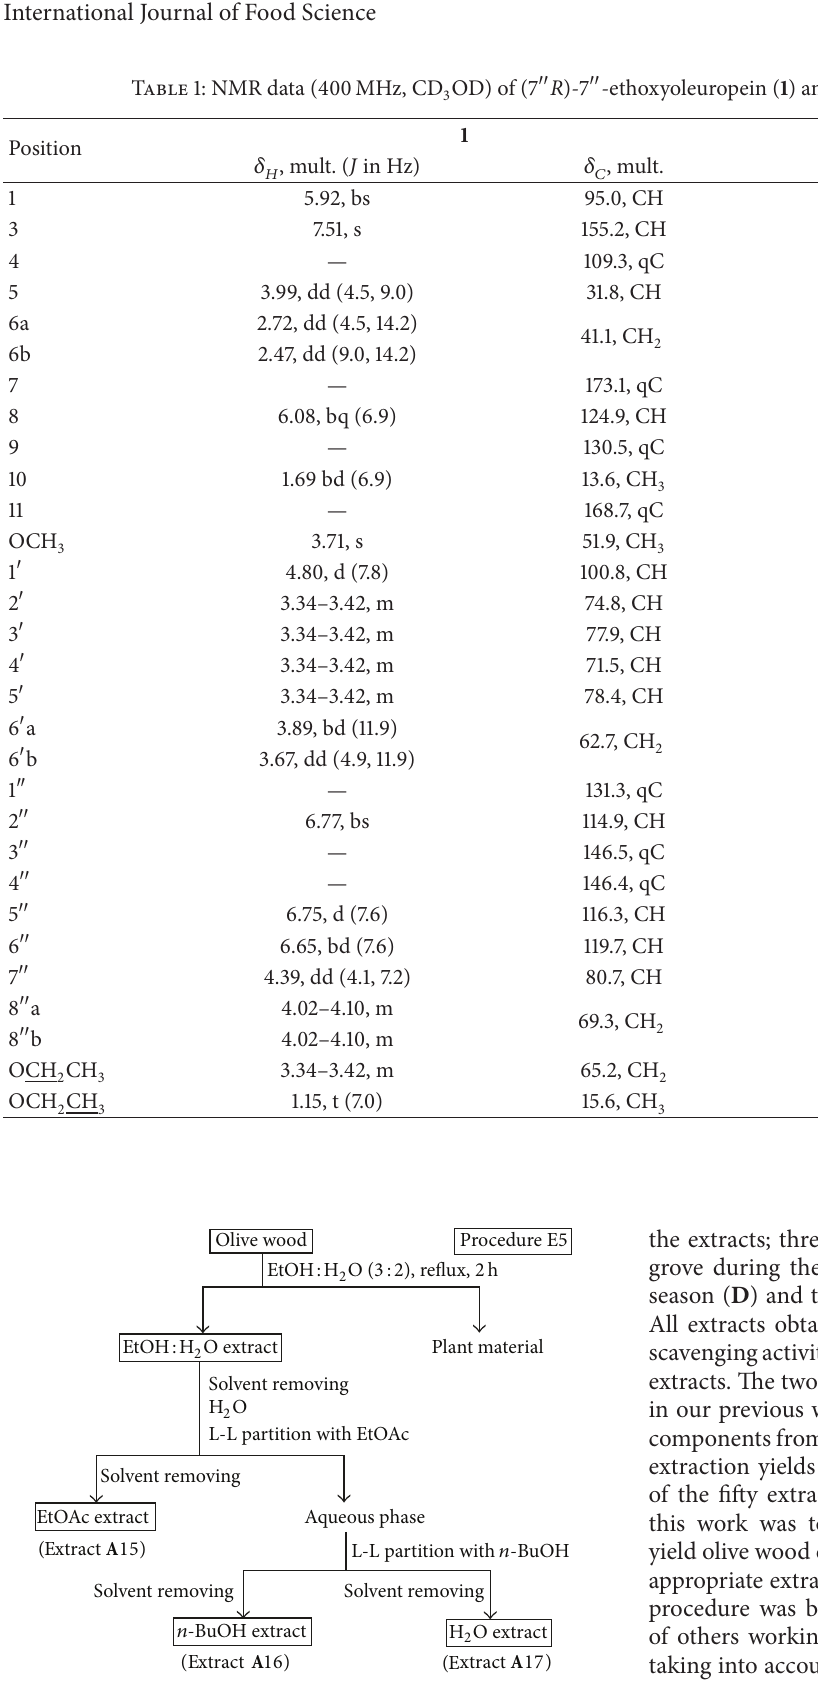
Figure 5: Solvent extractions of olive wood sample A following procedure